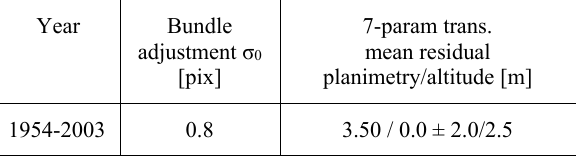
Table 2. Residuals after the bundle adjustment and 7-parameter